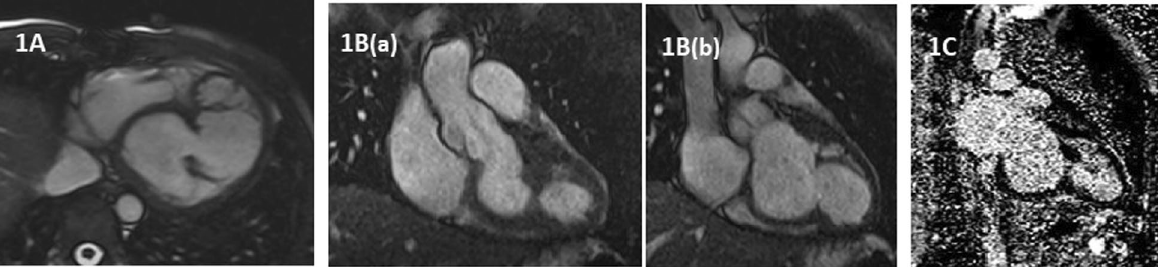
Fig. 1 A : CMR Axial view showing double chambered left ventricle. B : CMR LVOT view showing double chambered LV in systole (a) and diastole (b). C : Late gadolinium image showing double chambered LV with no hyperenhancement